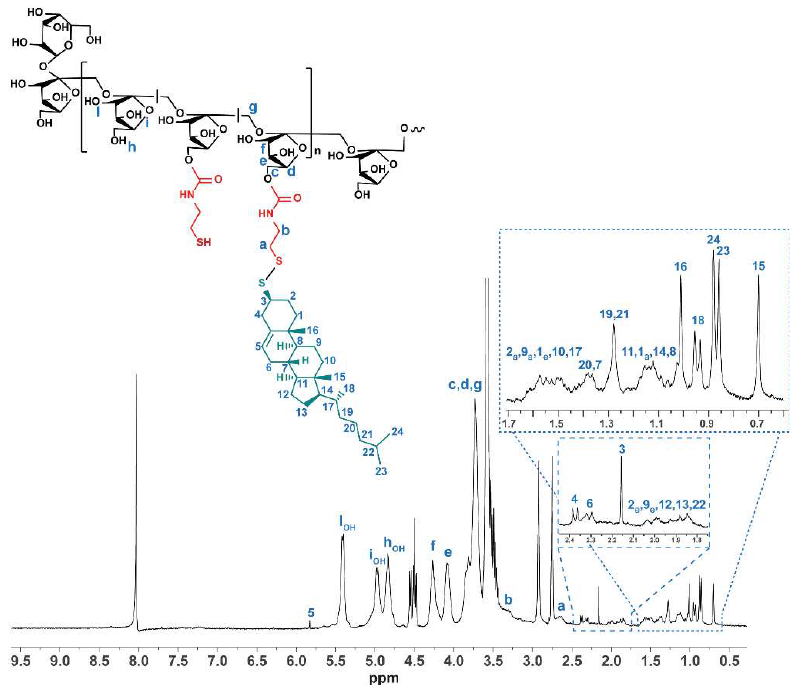
Figure 2. 1 H-NMR spectra of INU-Cys-TC (DMF-d 7 , 300 MHz). The structure and relative chemical shift assignments are reported as insertions.